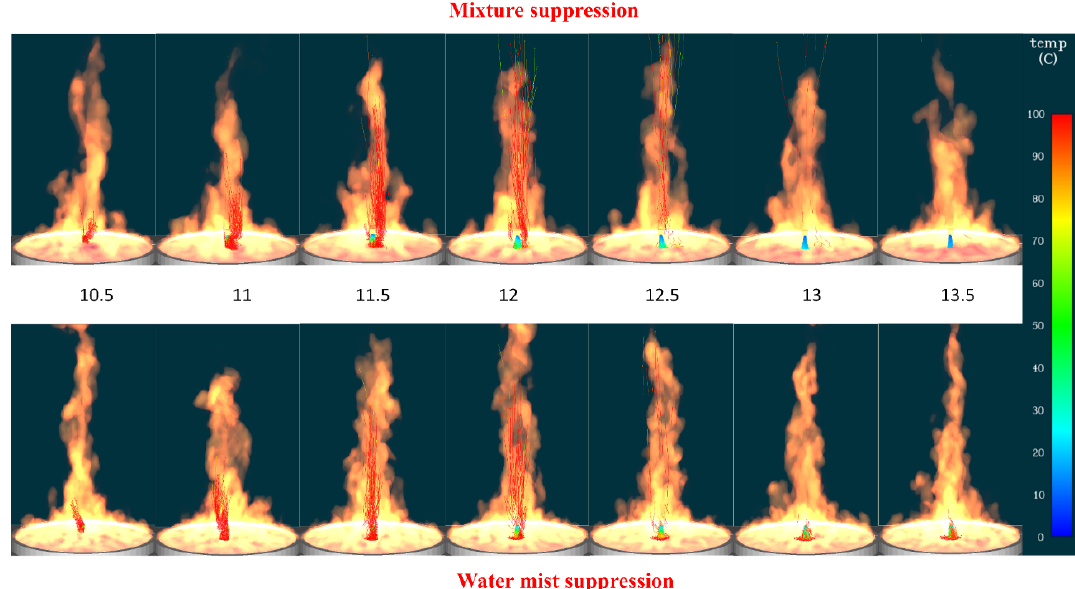
Figure 16. Temperature absorbed by the liquid droplets during both processes. The droplets are traced with 0.5 s. The temperature medium is shown at the right of the figure. The high temperature droplets are shown in red and low temperature droplets in blue. The maximum temperature sustained by the water particles is also shown on the left of Figure 16. As we